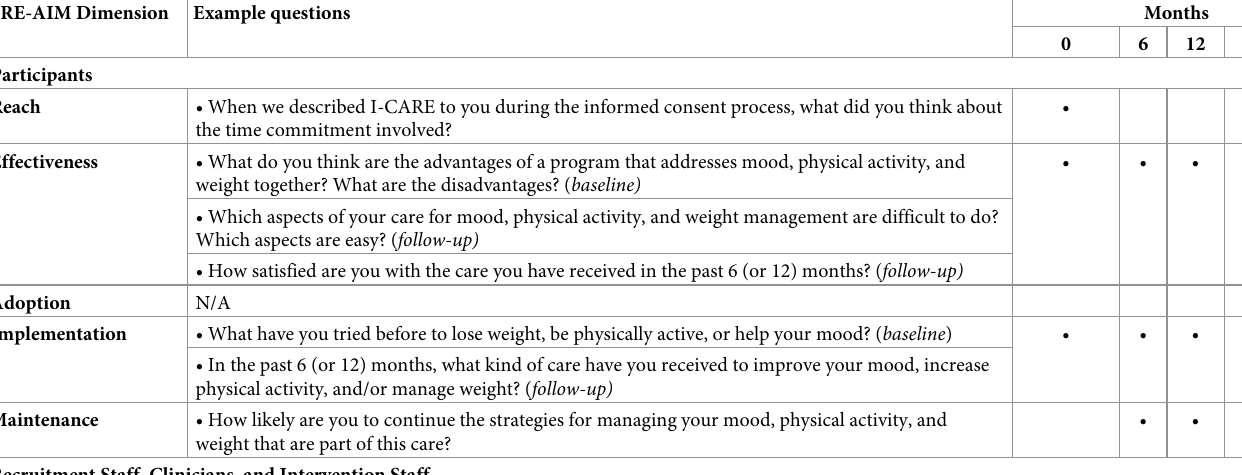
Table 2. Evaluation of RE-AIM dimensions, by timepoint and stakeholder group.